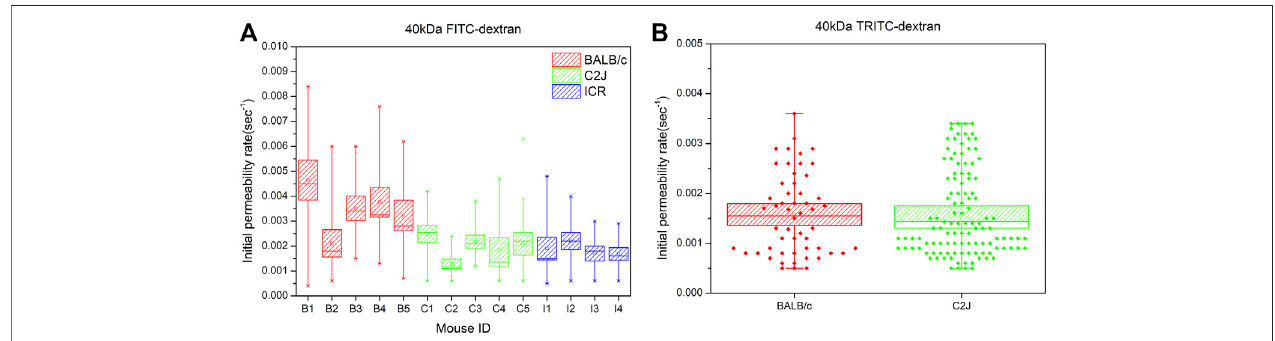
FIGURE 3 | (A) Comparison of the initial permeability rates of 40 kDa FITC-dextran between BALB/c (B1-B5), C2J (C1-C5), and ICR (I1-I4) mouse models. Signi fi cant differences were analyzed using the Mann – Whitney U test. Data are presented as mean ± SEM (B) Comparison of the initial permeability rates of 40 kDa TRITC-dextranbetweenBALB/candC2Jmousemodels.Thevalidmeasurementdataofeachmousewithinthesamegroupweremergedtogethertogeneratethebox chart. The data are presented as mean ± SEM. Signi fi cant differences were analyzed using the one-way ANOVA with Tukey ’ s multiple comparison tests.